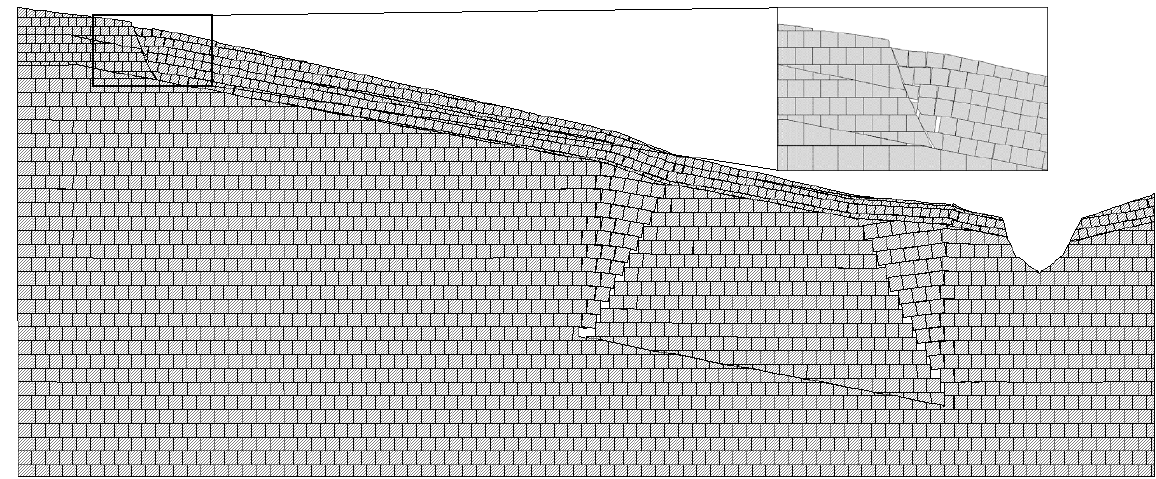
Figure 5. Numerical simulation results under the coal mining subsidence area. Numerical simulation results of landslide